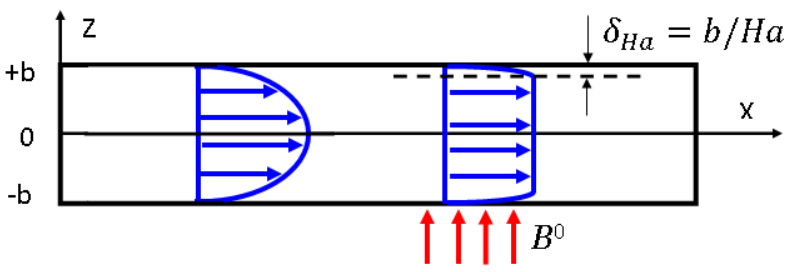
Figure 11. Sketch of a fully developed flow of electrically conducting viscous fluid between two infinitely long parallel plates. Without a magnetic field the velocity profile is parabolic (Poiseuille flow). With the magnetic field, the velocity profile has a uniform core and thin boundary layers with the thickness scaled as 1/ Ha (Hartmann flow).